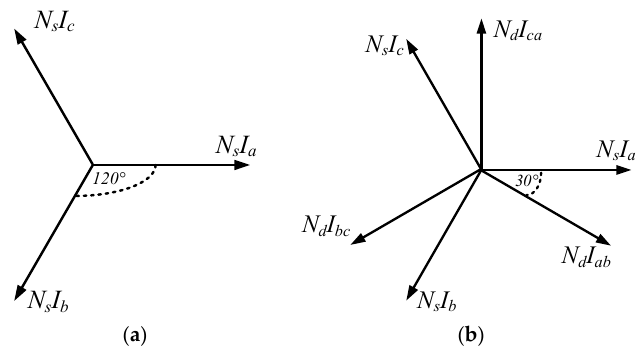
Figure 2. Phasor diagram of magnetomotive forces (MMFs) produced by star and combined star–delta windings. ( a ) Star connection; ( b ) Combined star–delta connection.